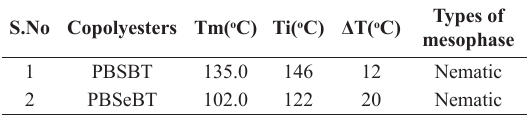
Table.5. Thermal properties of the synthesized copolyesters